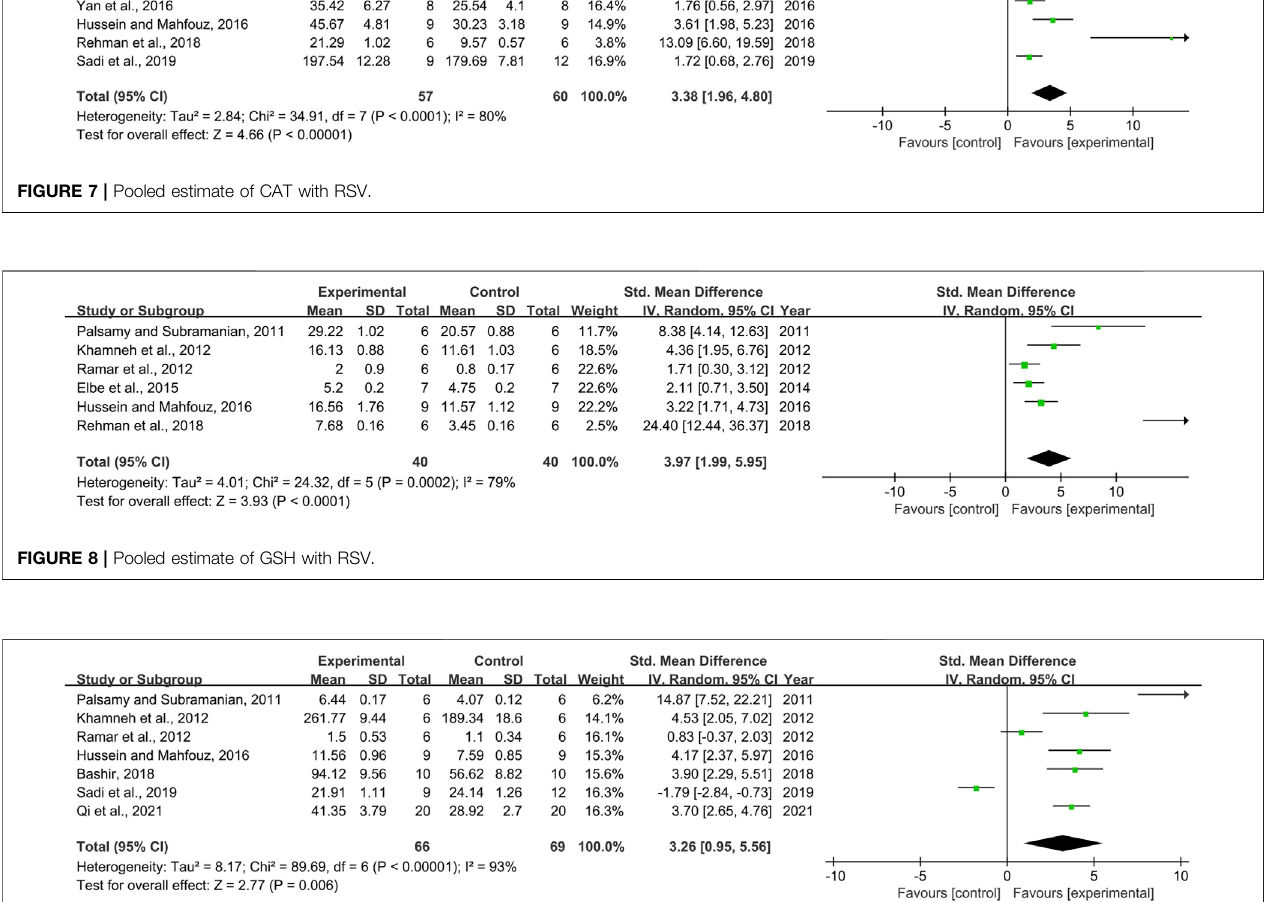
FIGURE 9 | Pooled estimate of GPx with